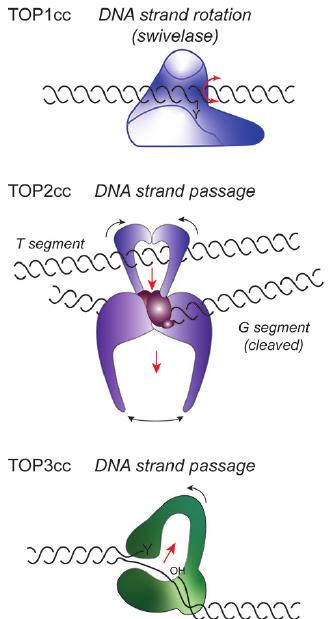
Figure 1. Topoisomerase mechanisms. In the topoisomerase I cleavage complex (TOP1cc) (top), the 3’ DNA end is covalently linked to the active site tyrosine (Y). Changes in the linkage of DNA strands occur through a mechanism of strand rotation, where the untethered 5’ DNA end of the cleaved strand swivels about the noncleaved DNA strand. TOP2 (middle) and TOP3 (bottom) both involve mechanisms of DNA strand transfer. In the case of TOP2cc, the G segment of duplex DNA is cleaved by the two active sites of the homodimer, following capture of the T segment by the closure of the N-terminal ATPase domains. The T segment DNA is then successively passed through the double-strand break in the G segment and out through the bottom dimer interface. For type IA enzymes, depicted for TOP3cc, a single strand of negatively supercoiled DNA is cleaved to form a 5’ phosphotyrosyl bond, while the 3’OH end is held by the enzyme. A conformational change in the protein then allows the intact complementary strand to be passed through the protein-linked break, followed by religation of the cleaved DNA.